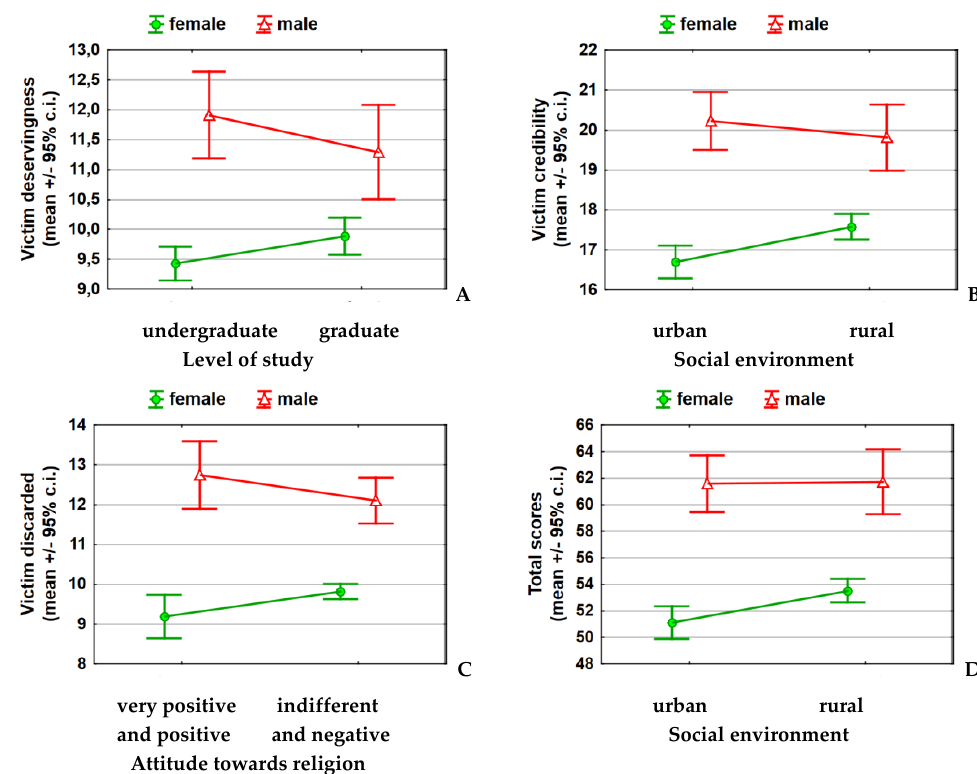
Figure 1. Linear regression model containing only statistically significant factors differentiating the ARVS dimension illustration of second−degree interactions. A. Victim deservingness: gender and level of study; B. Victim credibility: gender and social environment; C. Victim discarded: gender and attitude toward religion; D. Total stores: gender and social environment